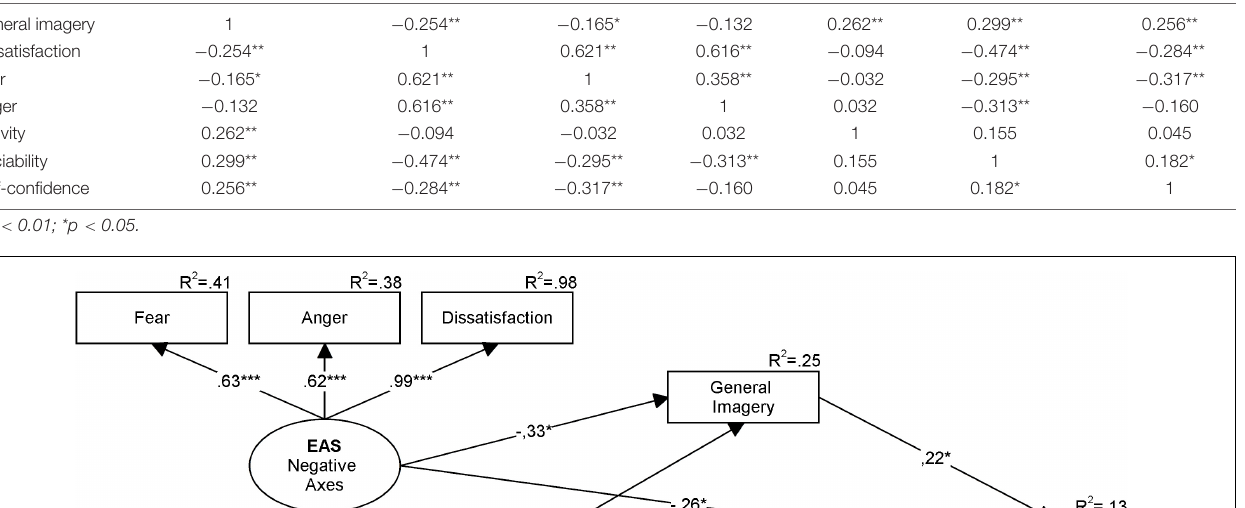
TABLE 2 | Correlations among general imagery, the emotionality, activity, shyness, and sociability (EAS) temperament, and self-confidence. General imagery Dissatisfaction Fear Anger Activity Sociability Self-confidence